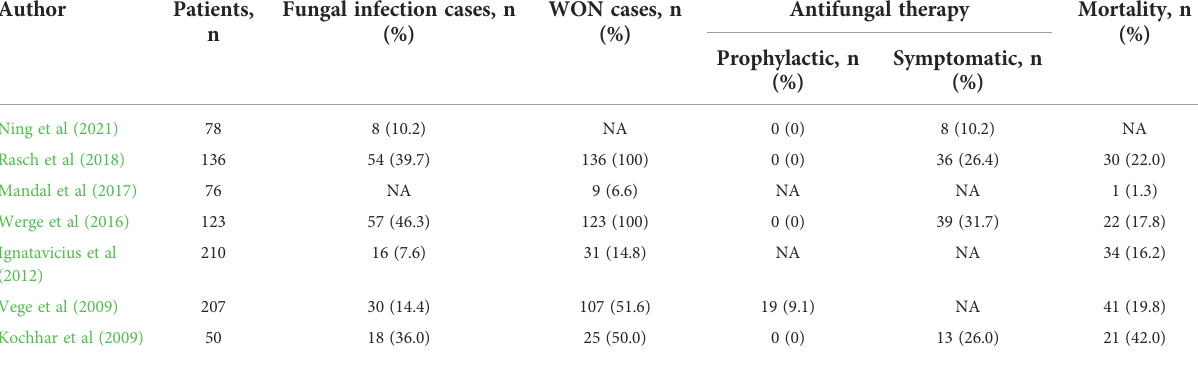
TABLE 1 Fungal infection in severe acute